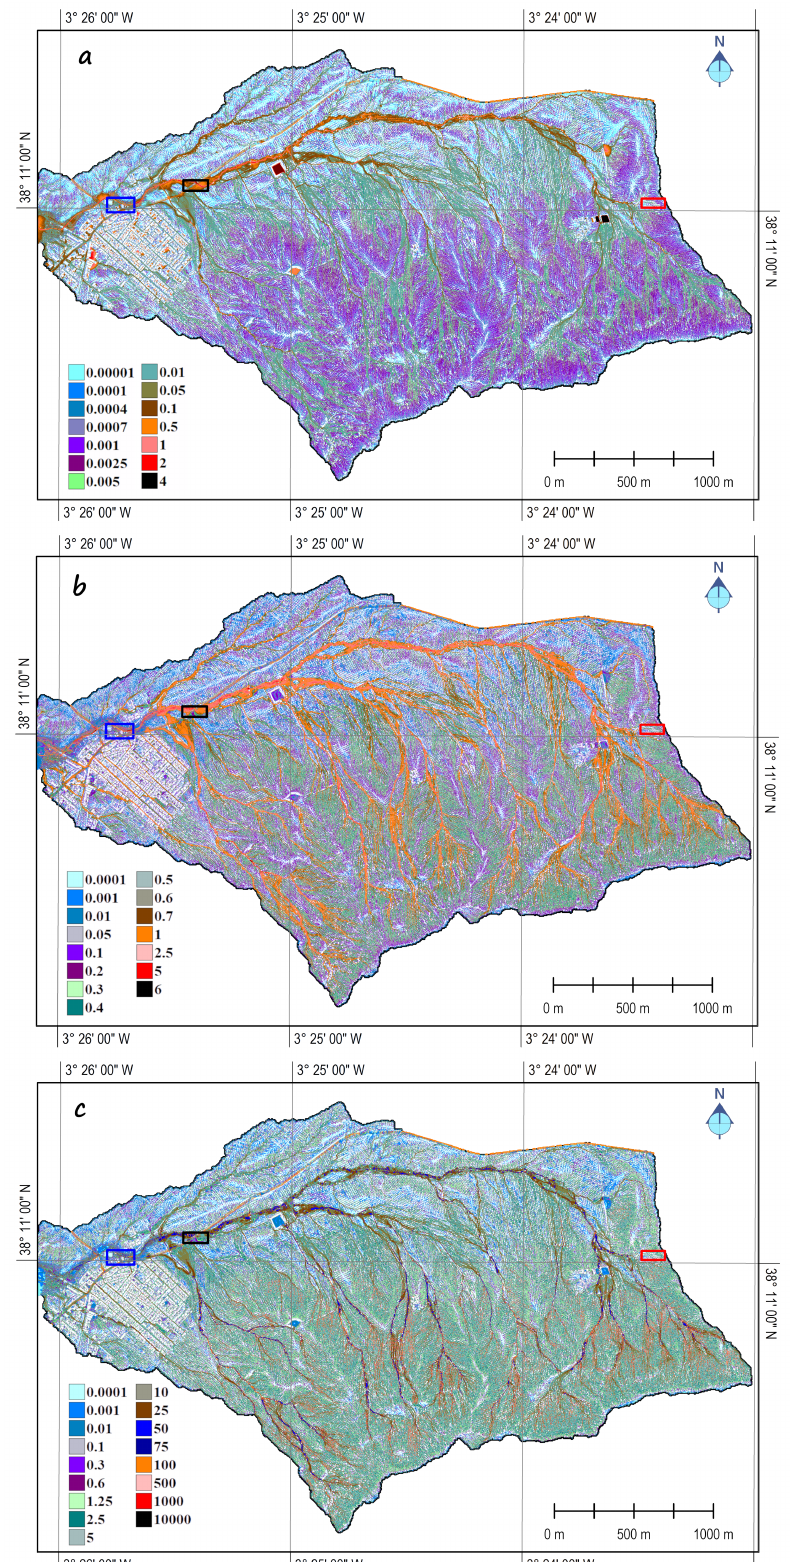
Figure 6. Map of the maximum values of the ( a ) flow depth h [m], ( b ) magnitude of the velocity vector | u | [m·s − 1 ], and ( c ) magnitude of the shear stress vector | τ b | [N·m − 2 ] at peak flow (i.e., t = 3 h) for the present-day soil use and management (simulation